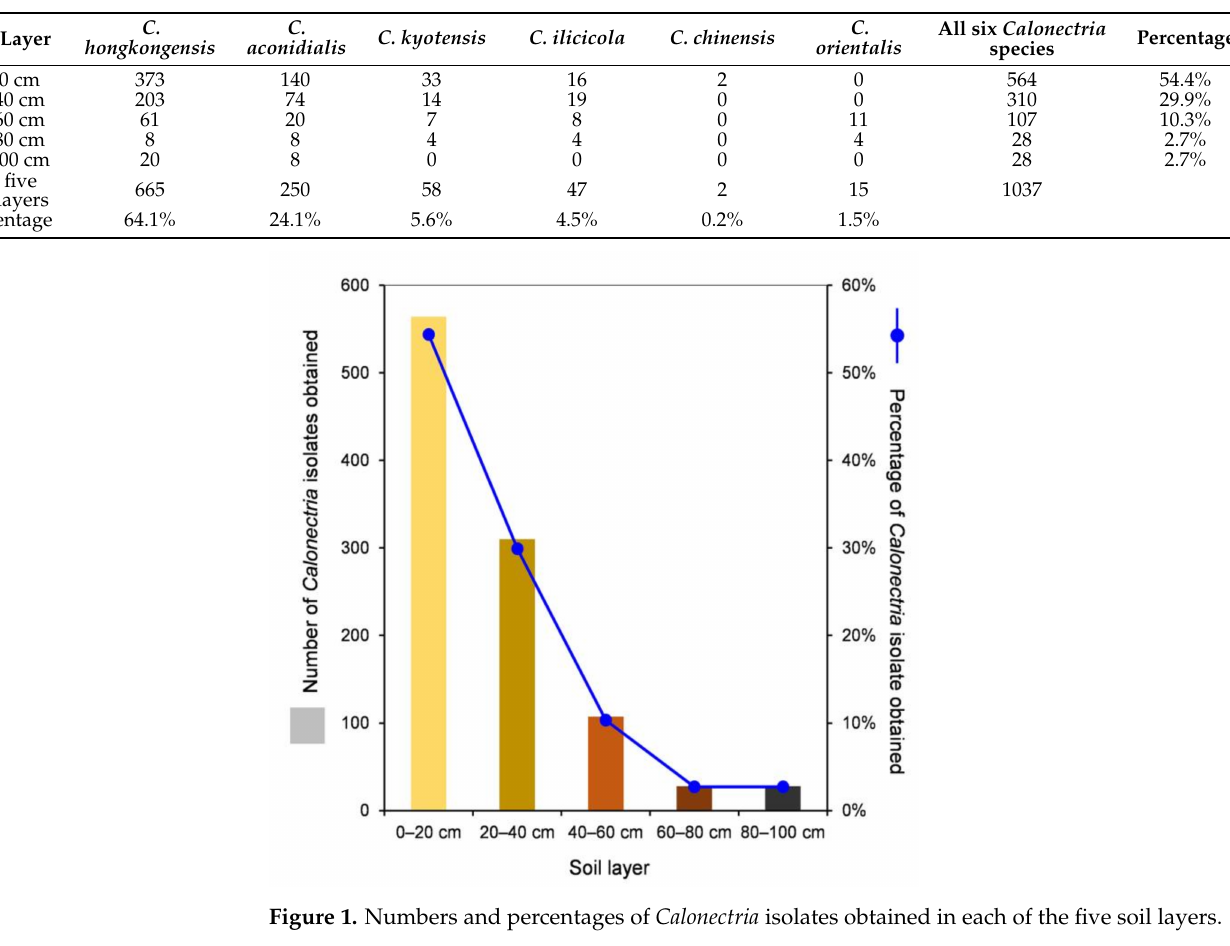
Table 1. Number of isolates obtained for each Calonectria species from each soil layer.